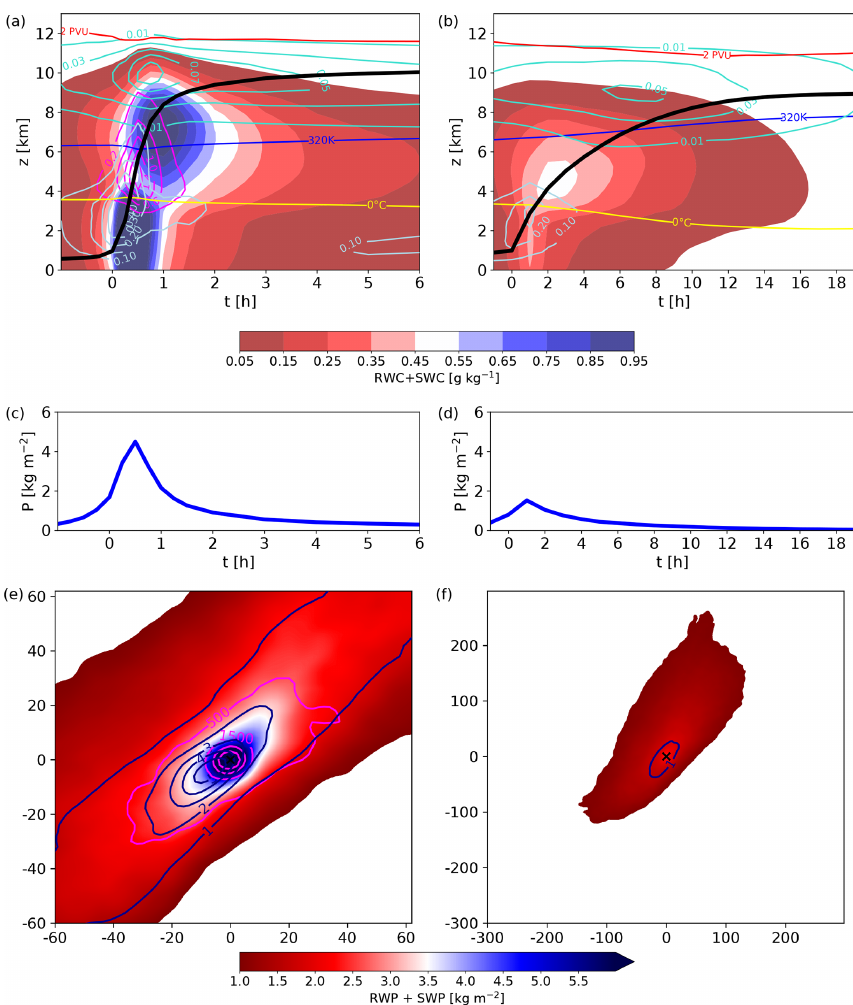
Figure 4. (a, b) Composites of vertical profiles following the motion of the trajectories (the black line shows the mean ascent of all WCB trajectories) for (a) convective WCB trajectories and (b) slantwise WCB trajectories for hydrometeors: sum of rain and snow water content (RWC + SWC, colors, in gkg − 1 ), ice water content (IWC, turquoise contours, every 0.02gkg − 1 ), liquid water content (LWC, light blue contours, every 0.1gkg − 1 ), graupel water content (GWC, magenta contours, every 0.4gkg − 1 ), 0 ◦ C isotherm (yellow line), 320K isentrope (blue line), and the 2PVU tropopause (red line). (c, d) The 15min accumulated surface precipitation along the ascent of the (c) convective and (d) slantwise WCB trajectories (blue line, in kgm − 2 ). (e, f) Horizontal cross section composites of vertically integrated rain and snow water content (RWP + SWP, colors, in kgm − 2 ), vertically integrated graupel water content (magenta contours, every 500gm − 2 ), and 15min accumulated surface precipitation (blue contours, every 1kgm − 2 ) for (e) convective WCB trajectories and (f) slantwise WCB trajectories 30min and 1h, respectively, after the start of the fastest 400hPa ascent (corresponding to the respective times of maximum surface precip- itation). The axes’ dimensions denote the distance from the WCB air parcel locations marked as “ × ” (in km). Note the different time axis of (a, c) and (b, d) and the different horizontal dimensions of (e) and (f)